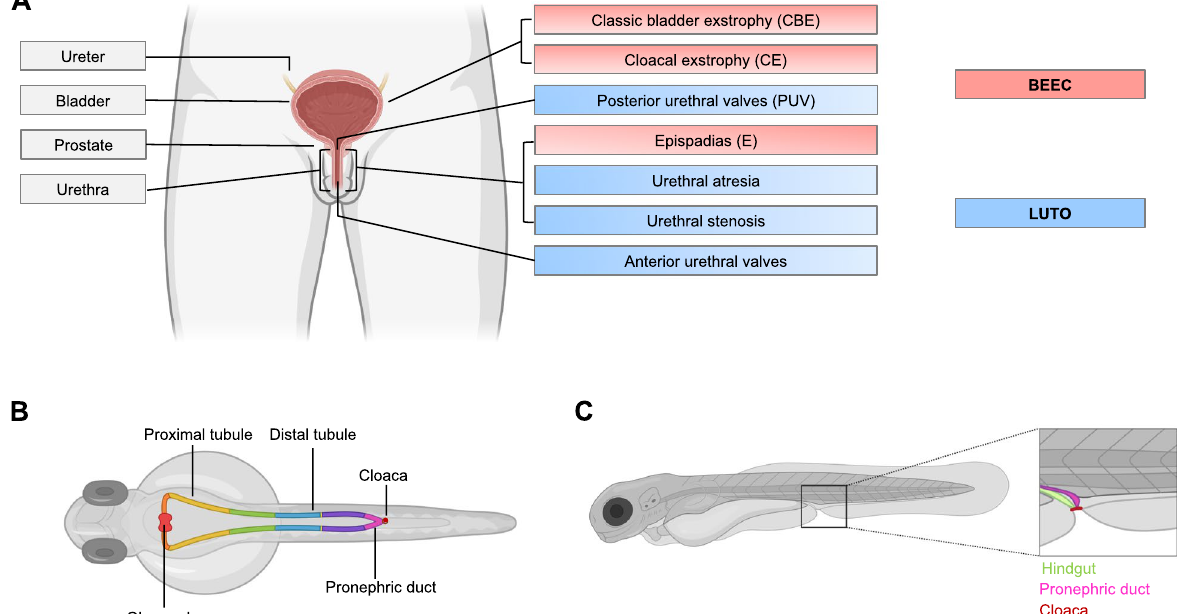
Fig. 1 Schematic overview of human and zebrafish urinary tract. A Schematics of human urinary system. Topological subdivisions of the phenotypic complexity of BEEC (red) and LUTO (blue) are depicted. B Overview of zebrafish urinary system. It is composed of 2 nephrons with a pair of glomeruli (bright red) and tubules that can be divided in a proximal and distal segment. The proximal part is subdivided into neck (orange), proximal convoluted (yellow) and proximal straight tubule (green). The distal portion is divided in distal early (blue), corpuscle of Stannius (brown) and distal late (purple). The last segment depicts the pronephric duct (pink) that distally fuses with the cloaca (dark red). C Schematic depiction of cloacal region at 120 hpf. The hindgut (green) opens to the exterior, adjacent to the pronephric duct (pink), both fusing with the cloaca (dark red). Created with